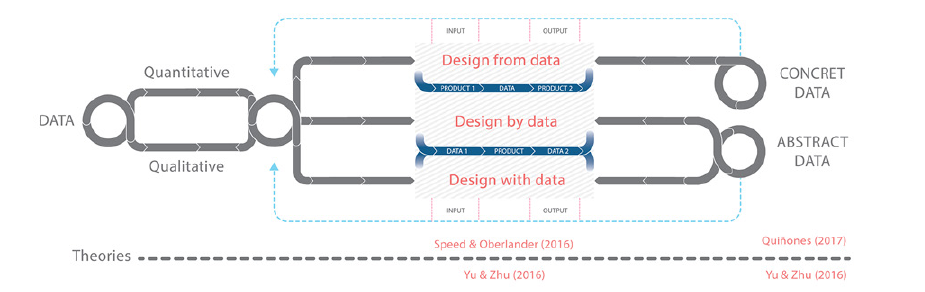
Figure 1. Data within the design process (source: created by author)